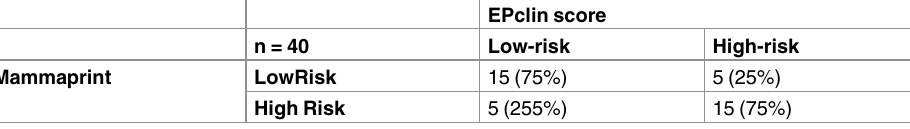
Table 4. Comparison of EPclin score and MammaPrint based risk